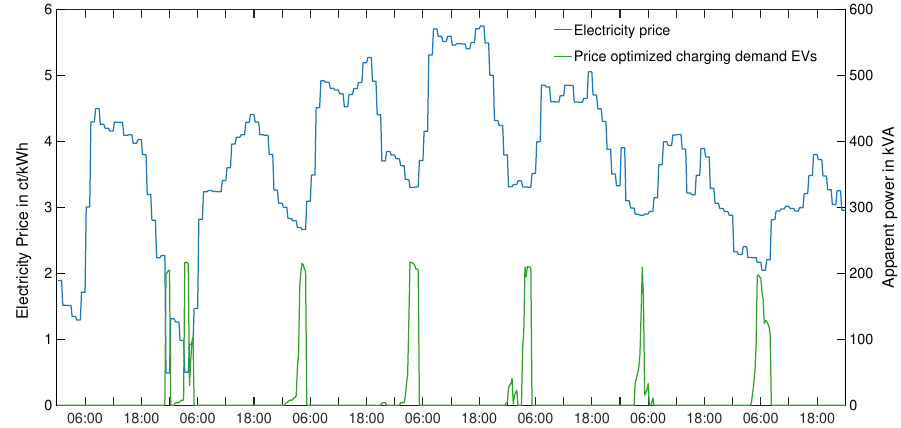
Figure 8. Comparison of electricity prices and cost optimized charging for a week in the